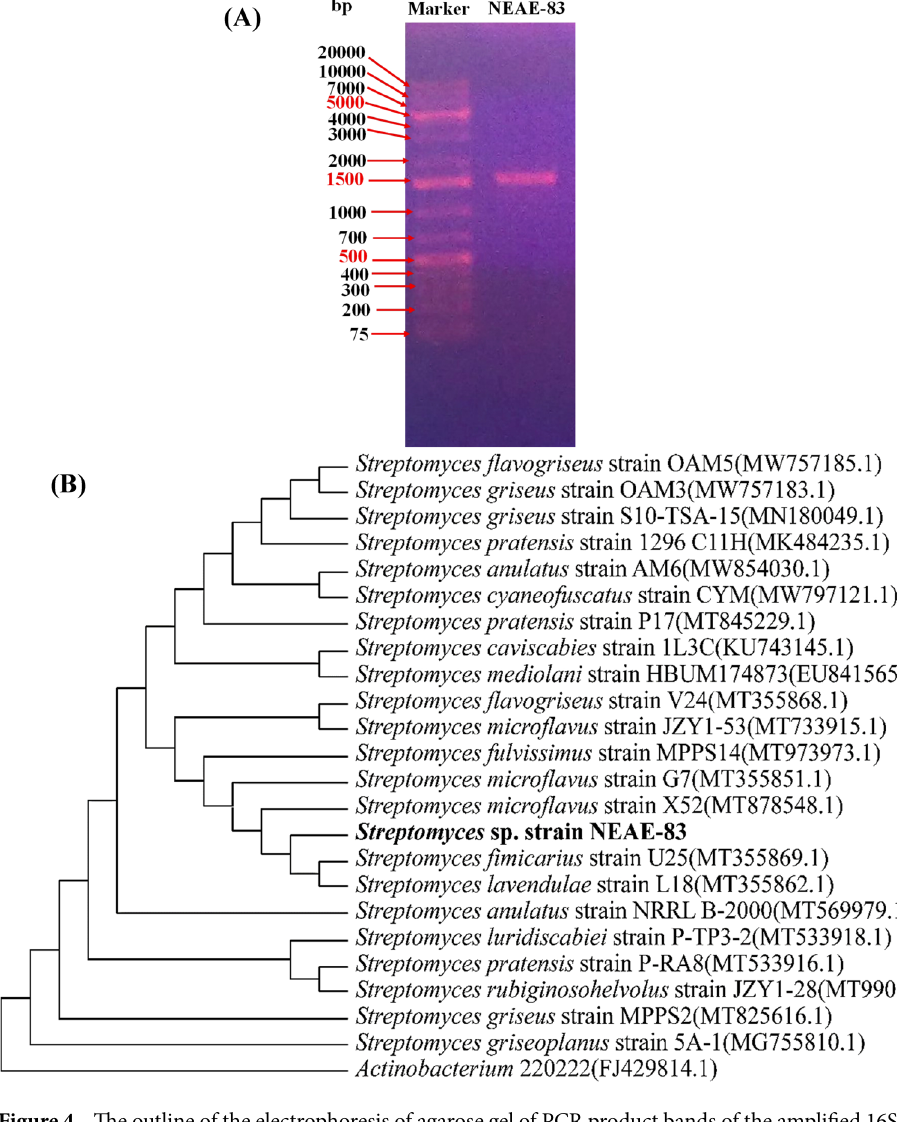
Figure 4. The outline of the electrophoresis of agarose gel of PCR product bands of the amplified 16S fragment (1214 bp) obtained from Streptomyces sp. strain NEAE-83 (MG384964) ( A ), and the neighbor-joining phylogenetic tree ( B